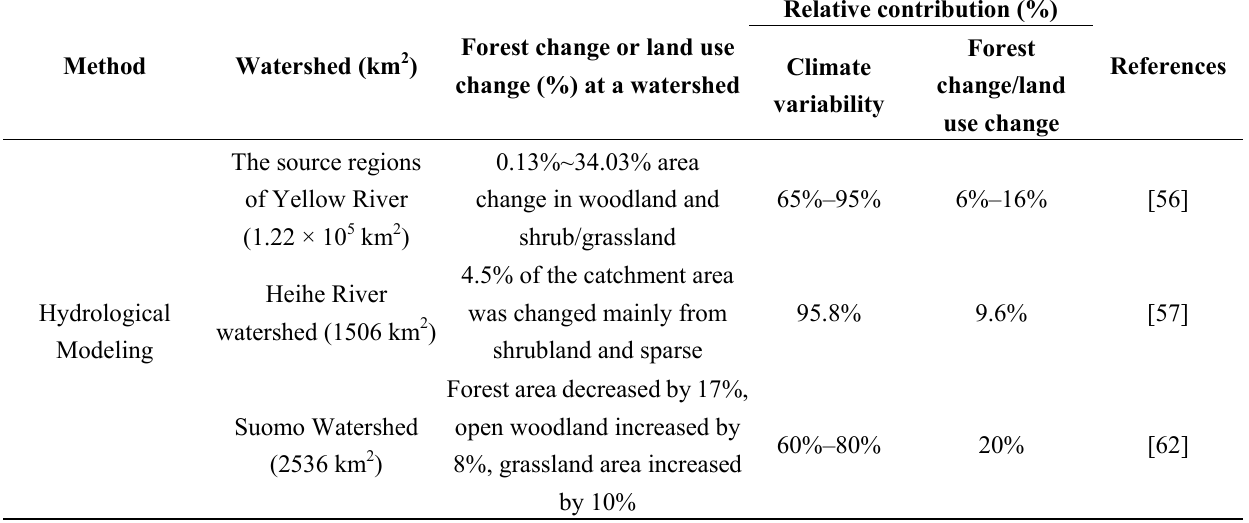
Table 1. Summary of the studies on relative contributions of forest or land cover changes and climate variability to